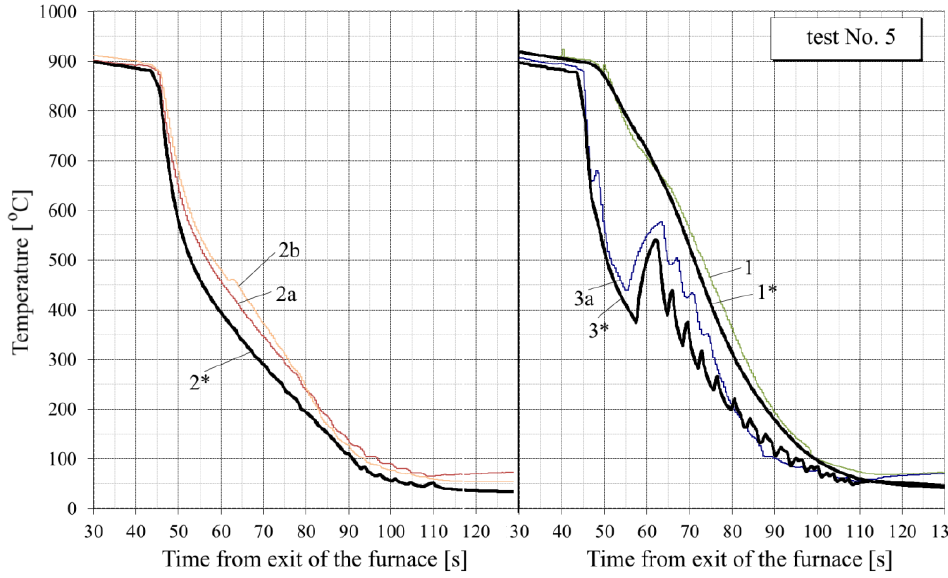
Figure 15. Graphs of cooling in test No. 5. The notations are the same as in Figure 14.